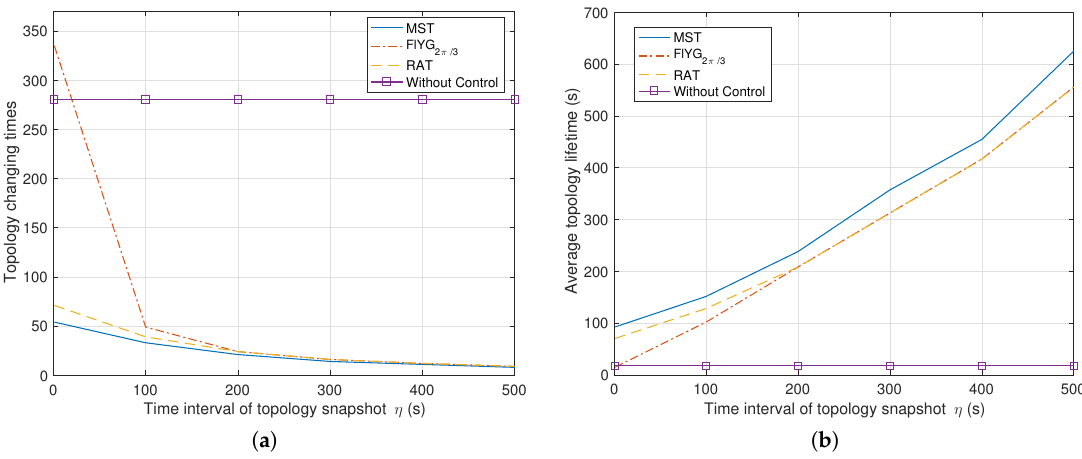
Figure 8. Topology changing results from three topology control algorithms (RAT, FlYG 2 π /3 , MST) showing total topology changing times ( a ) and the average topology lifetime ( b